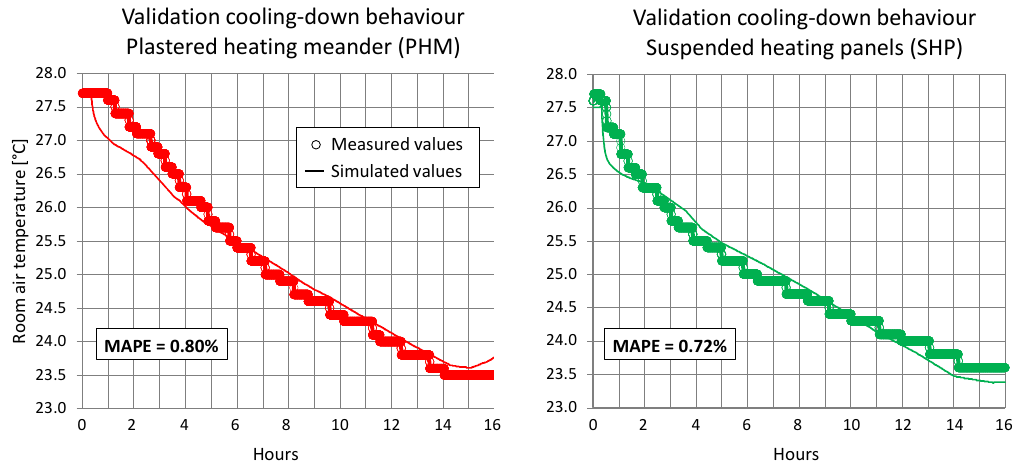
Figure A3. Cooling-down behaviour PHM (red) and SHP (green) for simulation and measurement at external temperatures of 16–20 °C.